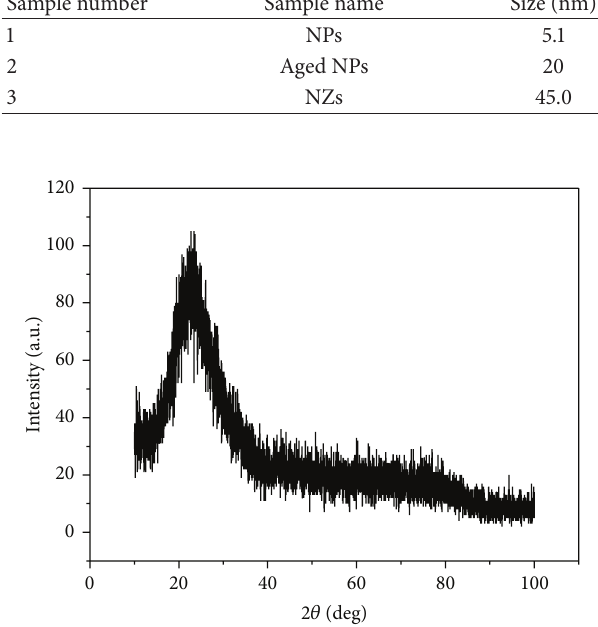
Figure 1: X-ray diffraction patterns of the nanocrystalline Beta zeo-